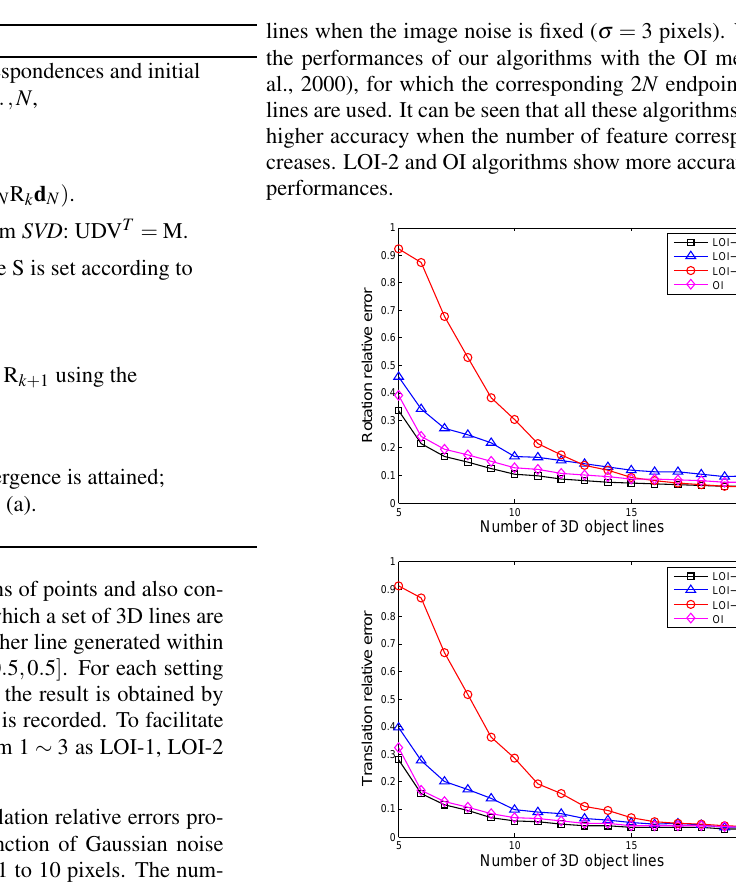
Figure 4: Relative rotation and translation error as a function of the number of object lines when the standard deviation of image noise is fixed to be 3